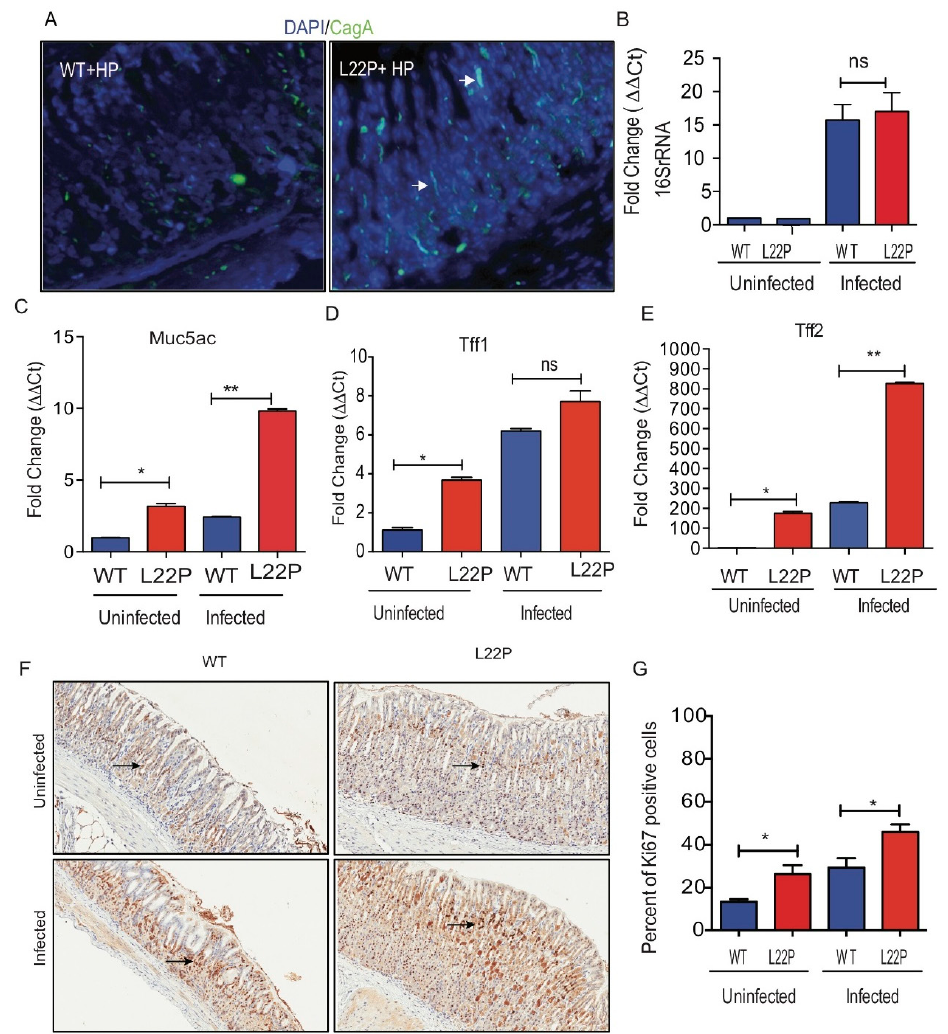
Figure 1. Mutation in POLB gene do not alter H. pylori colonization in stomach. ( A ) Immunocytochemistry of CagA localization of H. pylori on stomach tissues section from WT and L22P after 7 days of infection; ( B ) The quantitative reverse transcription polymerase chain reaction (qRT-PCR) of 16S rRNA to measure the copy number of H. pylori 16S rRNA in WT and L22P infected versus uninfected mice; ( C ) Gene expression of MUC5AC from surface epithelium of stomach tissues; ( D ) Tff1 mRNA expression; ( E ) Tff2 mRNA expression; ( F ,G) Immunohistochemistry staining of with proliferation marker ki67; ( G ) Estimated percent of cells positive for ki67staining. All data were analyzed using GraphPad prism (GraphPad Prism Inc, San Diego CA, USA). * p < 0.05; ** p < 0.01 and “ns” represent non-significant di ff